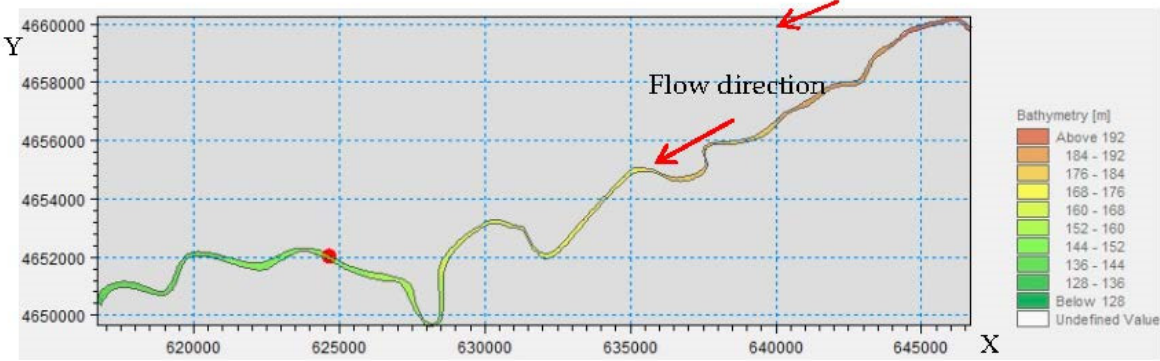
Figure 6. Location map of COD pollution source.